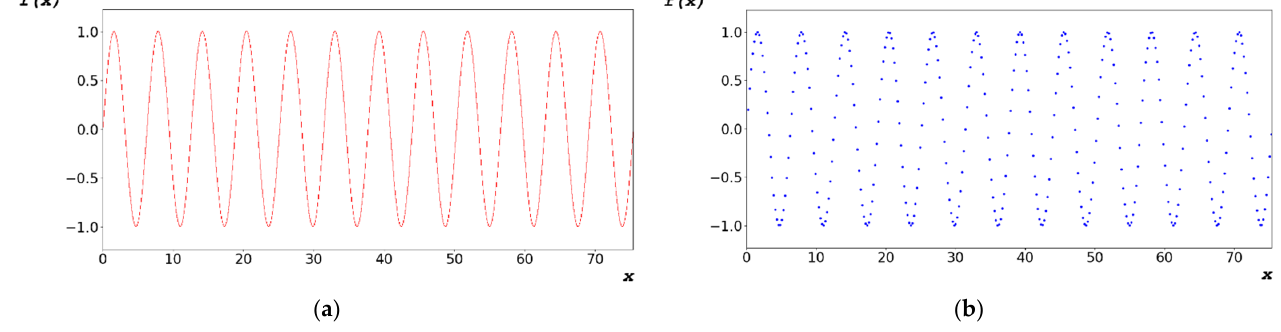
Figure 5. ( a ) Mathematical continuous periodic function; and ( b ) discontinuous periodic function.